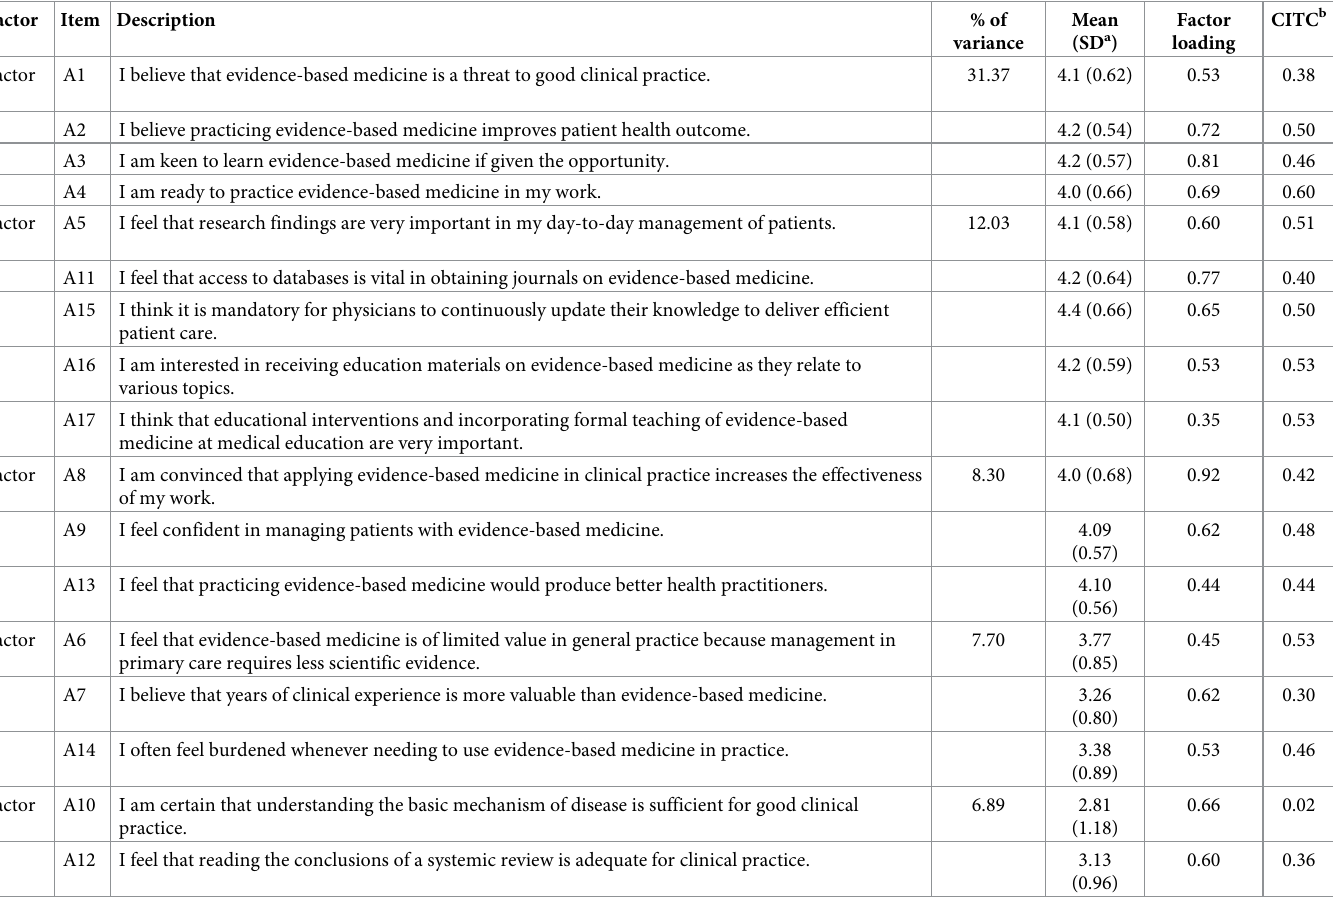
Table 2. Psychometric properties of the attitude domain on EBM. Factor Item